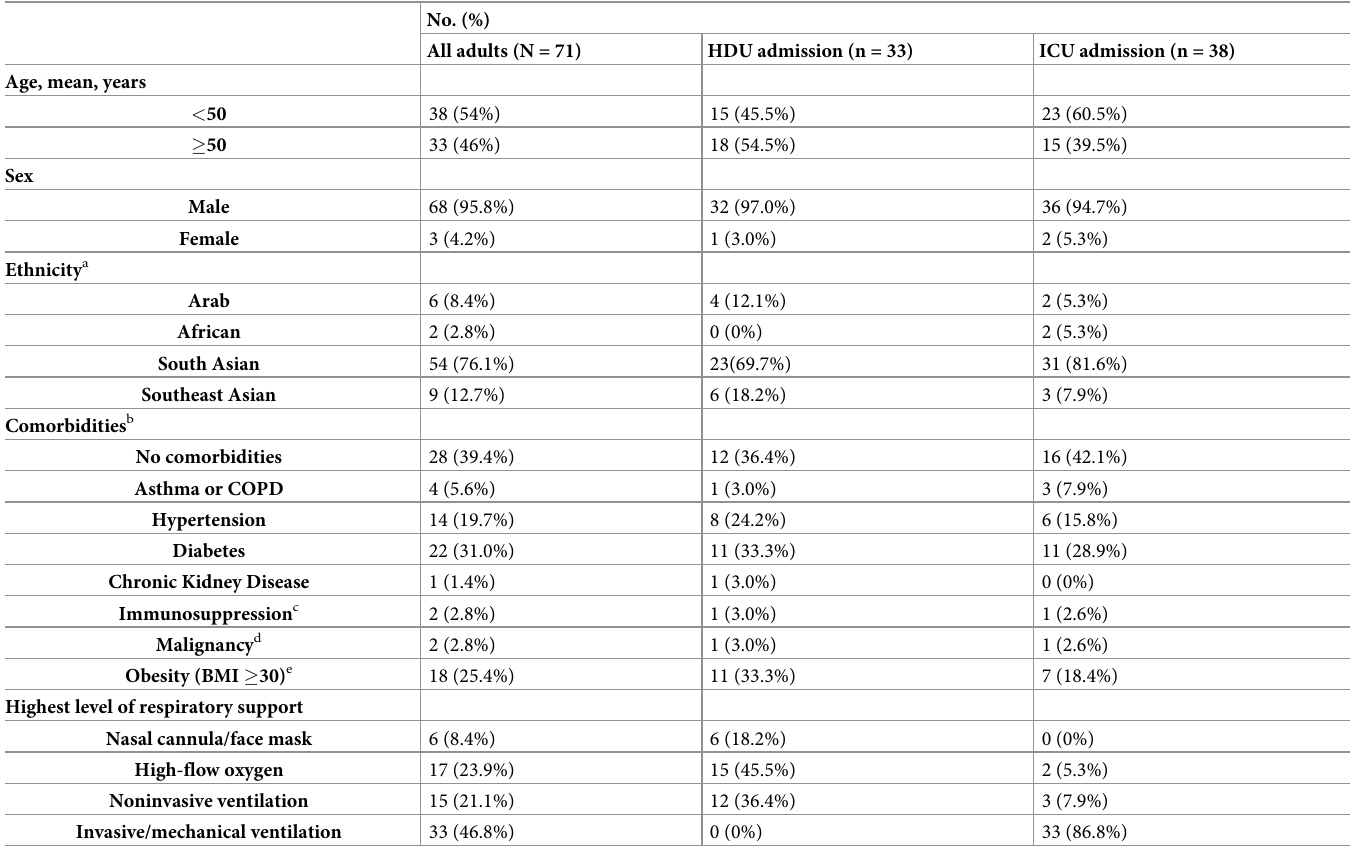
Table 1. Characteristics of adult patients transferred from critical care units to general medical